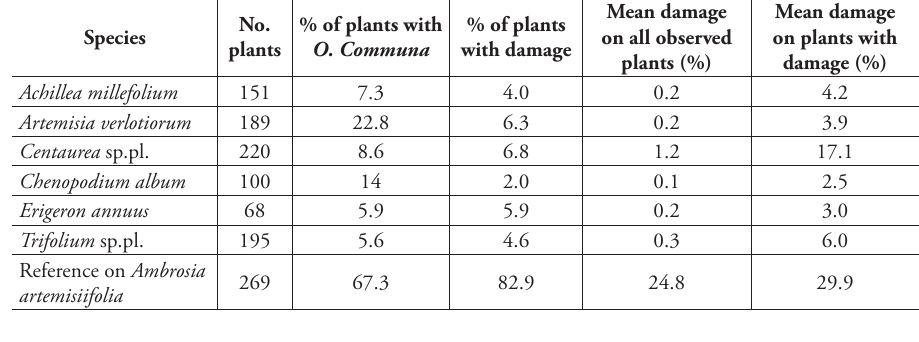
Table 2. O. communa density and damage on non-target species. Non-target species with total number of monitored individuals, percentage of individuals with O. communa and with damage and mean percent- age damage on observed and attacked plants during summer 2015.